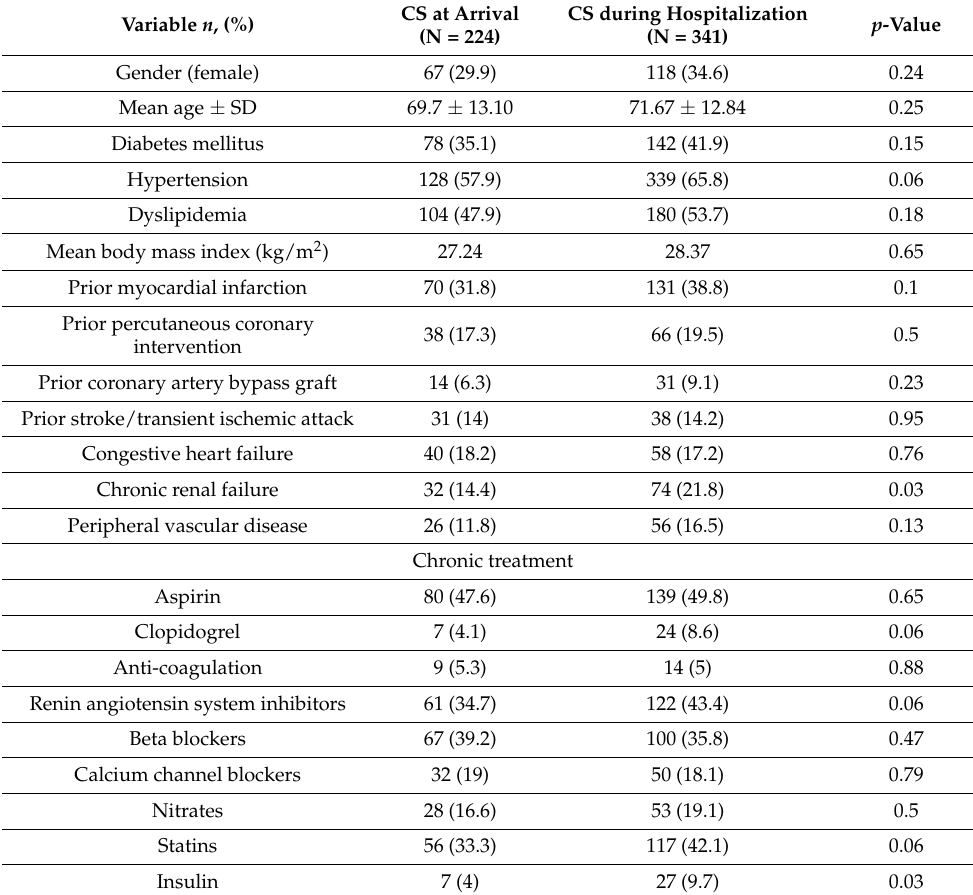
Table 1. Demographics and clinical characteristics of patients with ACS and CS at arrival versus patients who developed CS during